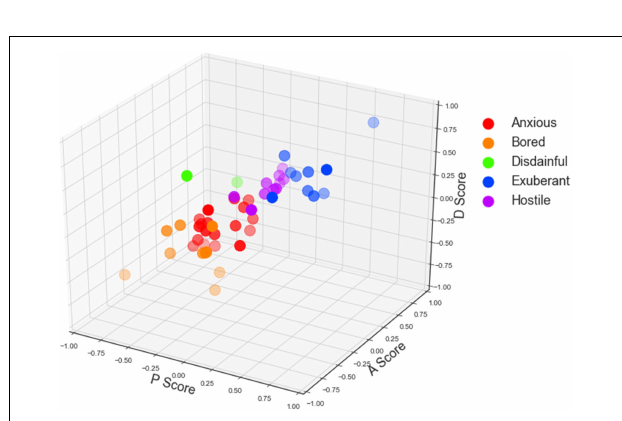
FIGURE 6 | The scatter plot of participants’ Pleasure-Arousal-Dominance (PAD) scores of the service environment.